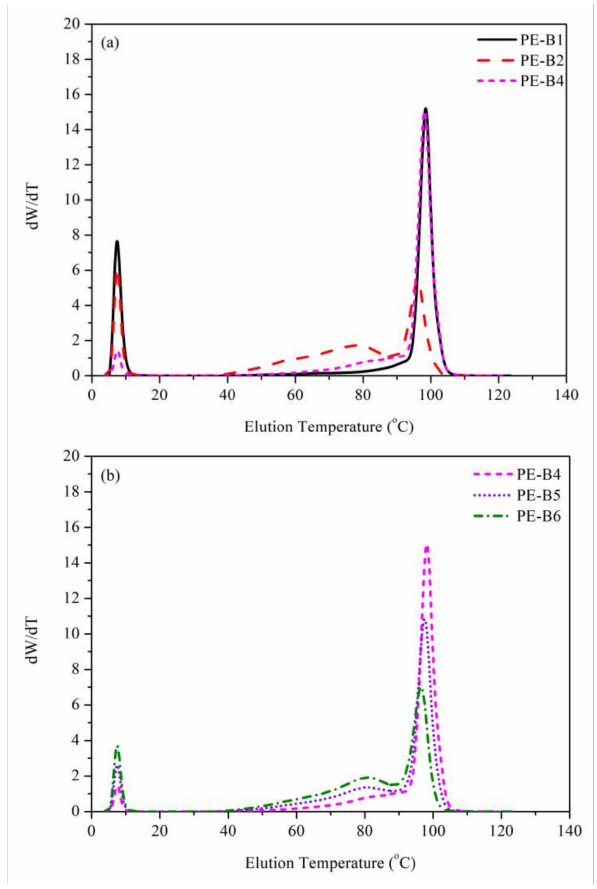
Figure 2. CEF characterizations of samples ( a ) PE-B1, PE-B2, PE-B4; ( b ) PE-B4, PE-B5, PE-B6. Viscous flow activation energy (Ea) is used to describe the viscosity–temperature dependence of a polymer using the rheometer. Its apparent viscous flow activation energy is higher, so the influence of temperature on the characteristics of the melt is